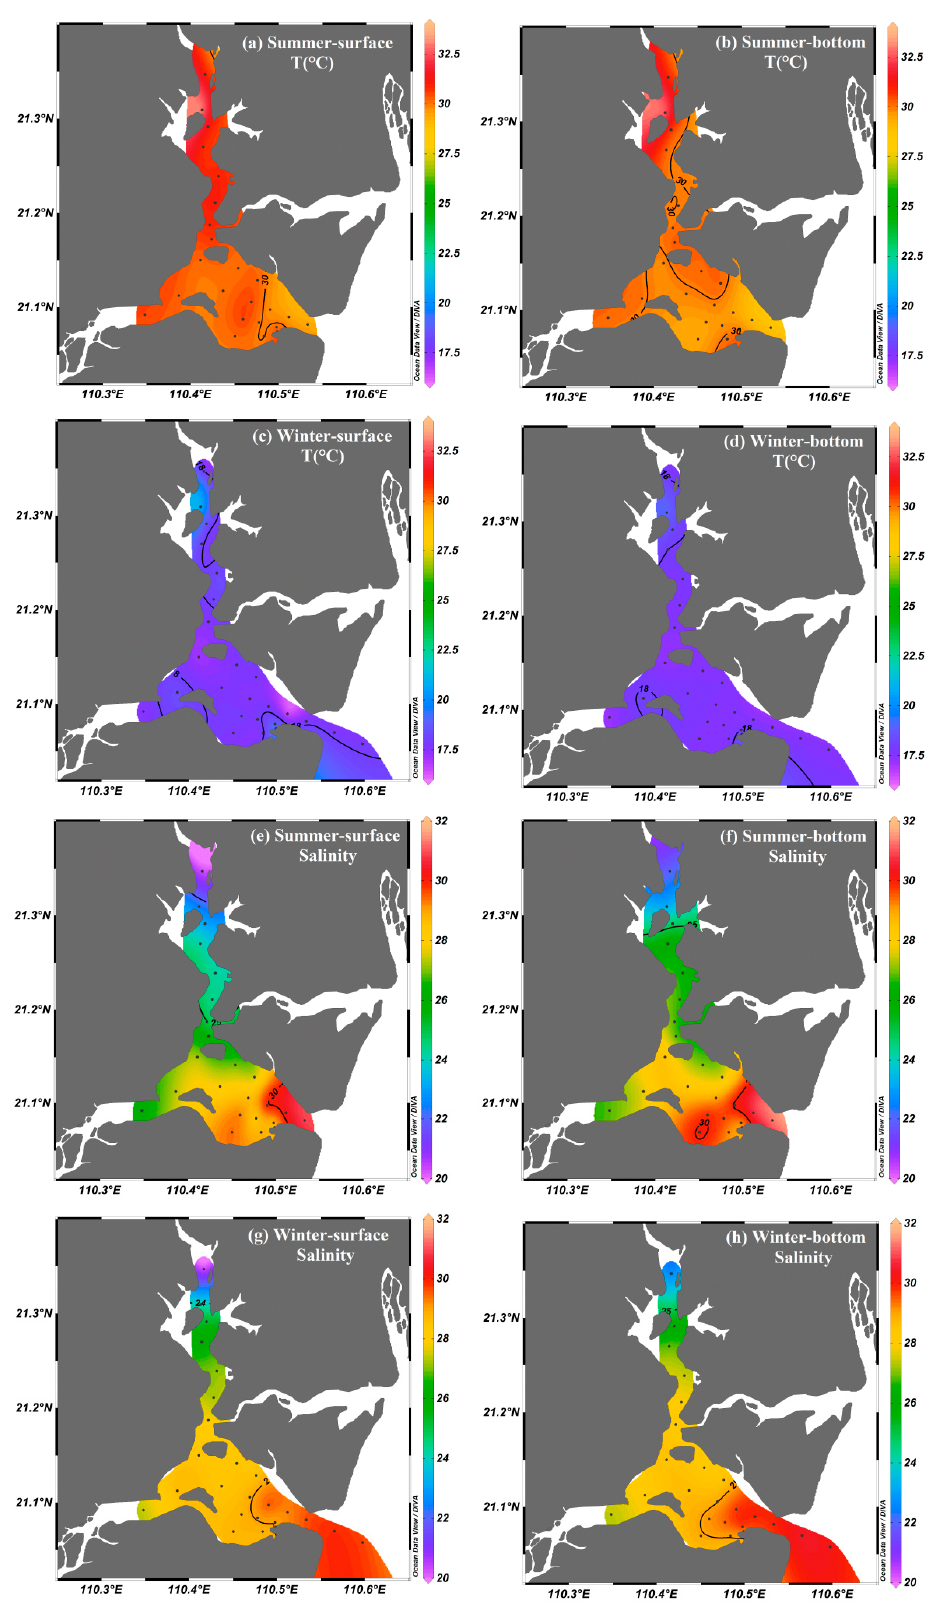
Figure 2. Spatial and seasonal distributions of temperature and salinity in the surface and bottom water of Zhanjiang Bay.